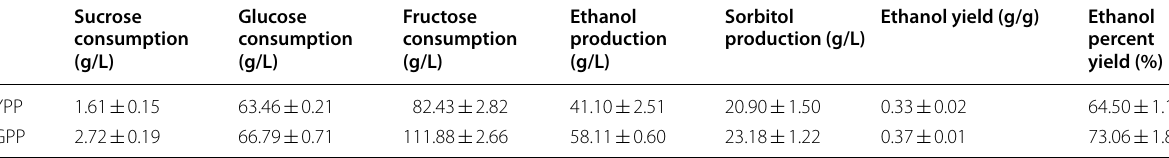
YPP yellow pear paste, GPP green pear paste